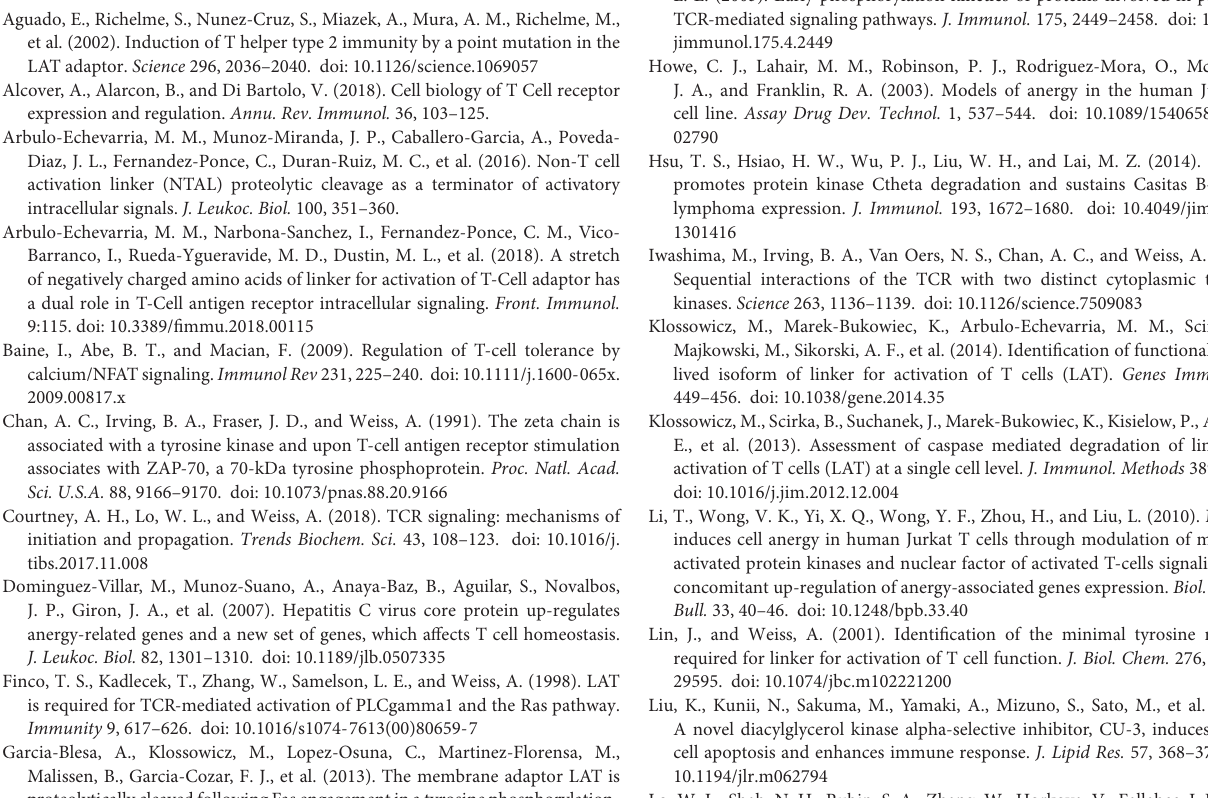
(C) Non transduced J.CaM2 and J.CaM2 cells expressing WT-LAT or the LAT G131D mutant were lysed and LAT expression was analyzed by Western blot with the anti-LAT mAb LAT-01 (left upper panel), anti-6His (middle upper panel), and the 11B.12 anti-LAT mAb (right upper panel). Membranes were stripped and blotted with anti- β -actin mAb to show equal protein load (lower panels). FIGURE S2 | Specific increase in TCR signaling in J.CaM2 cells expressing the LAT G131D mutant. (A) Immunoblots analyzing phosphorylation of LAT at tyrosine residue 171 in cells stimulated with soluble anti-CD3 were done with phospho-specific antibody. Equal amounts of the same samples were run in parallel and analyzed for total LAT expression by Western blot (lower panel). Numbers below each panel represent quantification of corresponding bands. Representative images from one of the three experiments performed with similar results. (B) Western blot analysis of PLC- γ activation (upper panel). Membranes were stripped and blotted with anti- β -actin mAb to show equal protein load (lower panel). Numbers below each panel represent quantification of corresponding bands. Representative images from one of the three experiments performed with similar results. (C) J.CaM2 cells expressing WT-LAT or the LAT G131D mutant were loaded with Indo-1AM and stimulated with the indicated concentrations of anti-CD3 mAb at the indicated time (black arrows). The intracellular Ca 2 + concentration was determined at 37 ◦ C through the change in Indo-1AM fluorescence. Graphs represent the average of 3 and 5 experiments, for OKT3 concentrations of 0.5 and 0.125 µ g, respectively. FIGURE S3 | Stable expression of LAT after long-term CD3-stimulation. Immunoblots analyzing expression of LAT (upper panel) and β -actin (lower panel) in cells treated overnight with the indicated doses of immobilized anti-CD3 antibody. Molecular weights in kDa are indicated on the side of the upper